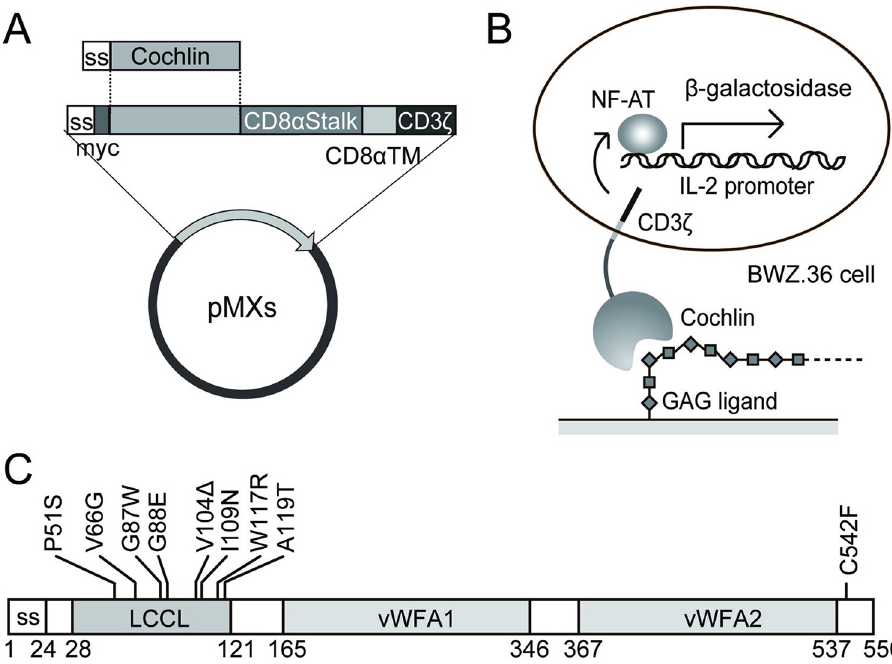
Fig 1. Establishment of cochlin reporter cells and domain organization of cochlin showing point mutations of DFNA9 patients. (A) Expression plasmid for the expression of chimeric cochlin/CD8 α /CD3 z protein. (B) Schematic illustration of the cochlin reporter cell, cochlin-BWZ. Cochlin is anchored on the cell surface by fusion with the stalk and transmembrane regions of CD8 α followed by the intracellular domain of CD3 z . Crosslinking of cochlin with